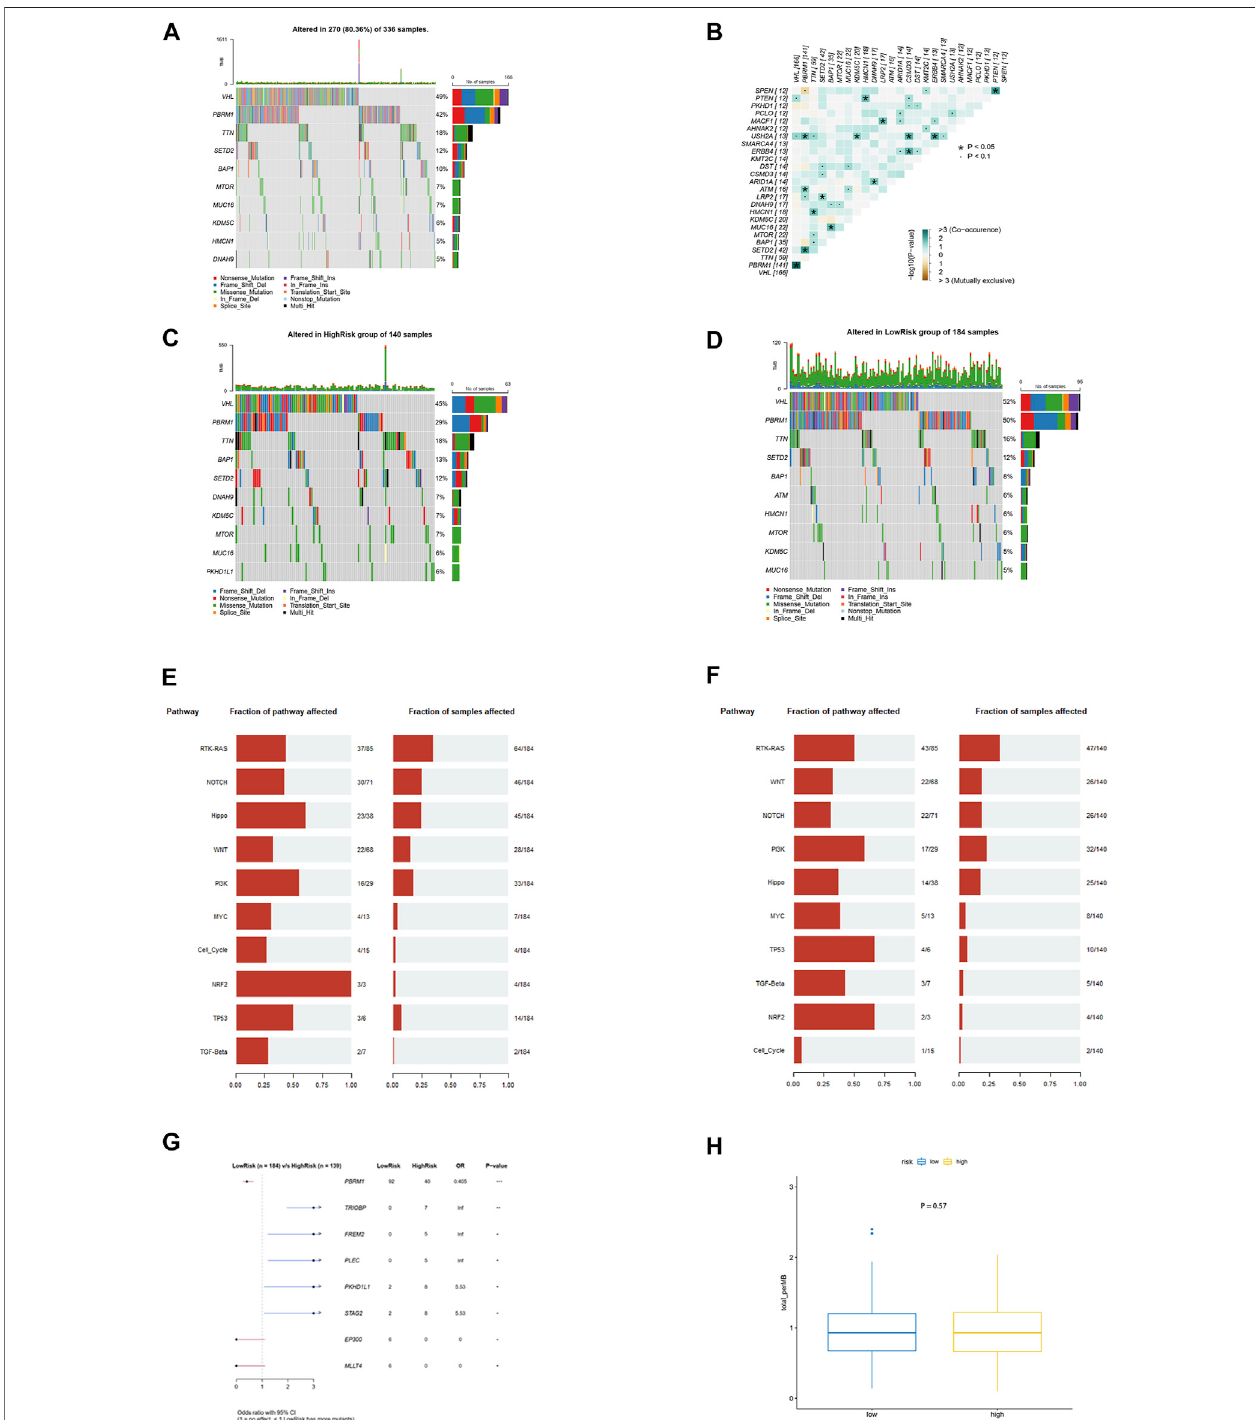
FIGURE 8 | Mutation landscape analysis. (A) Top 10 genes with the highest alteration frequency in the TCGA-KIRC cohort. (B) Information of mutation co- occurrence. (C,D) Top 10 genes with the highest alteration frequency in the high-risk group and the low-risk group. (E,F) Top 10 signaling pathways enriched by mutation genes in the high-risk group and the low-risk group. (G) Eight mutation genes as independent predictive factors for risk scores (H) Tumor mutational burden between the two groups.